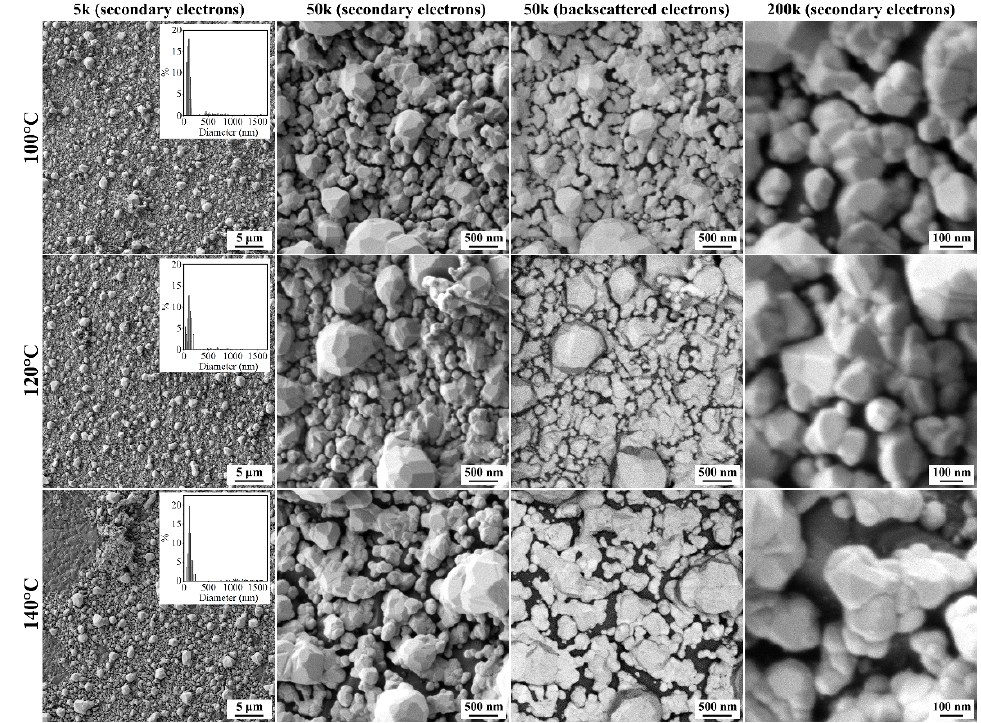
Figure 4. SEM micrographs of Ag films grown at different temperatures (using different detectors).